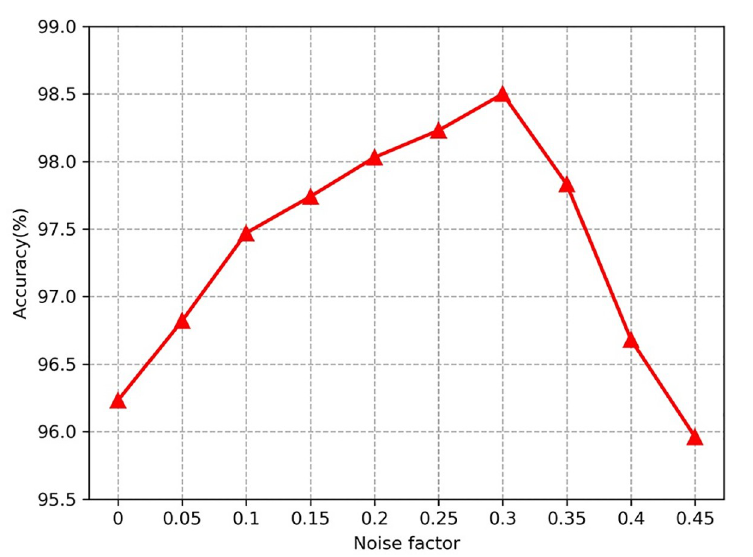
Fig 11. Diagnosis accuracy of ACGAN-SDAE under different noise